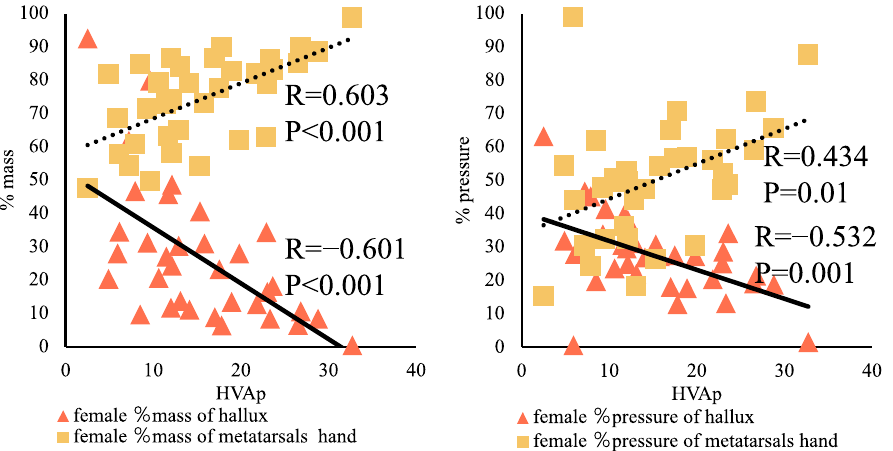
Figure 5. Relationship between the hallux angle and the %mass and %pressure impulse in females with first metatarsophalangeal joint plantar pain .